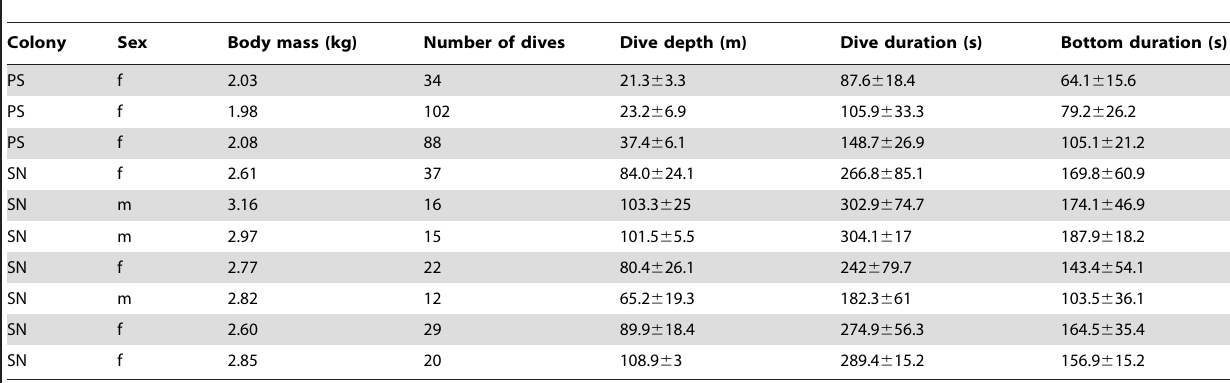
Table 1. Mean maximum dive depth, mean dive duration and mean bottom duration for the 10 study birds ( 6 S.D.).